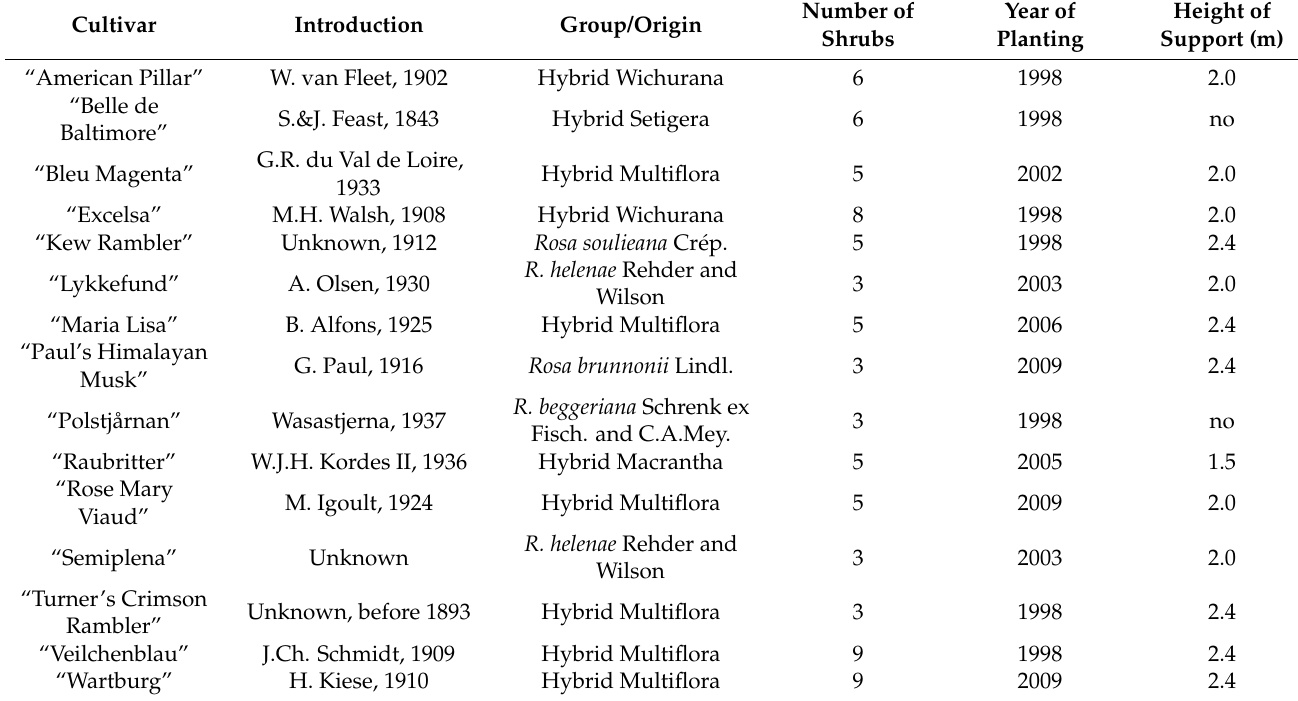
Table 1. The rambler roses observed in the National Collection of Rose Cultivars of PAS Botanical Garden CBDC in Powsin.